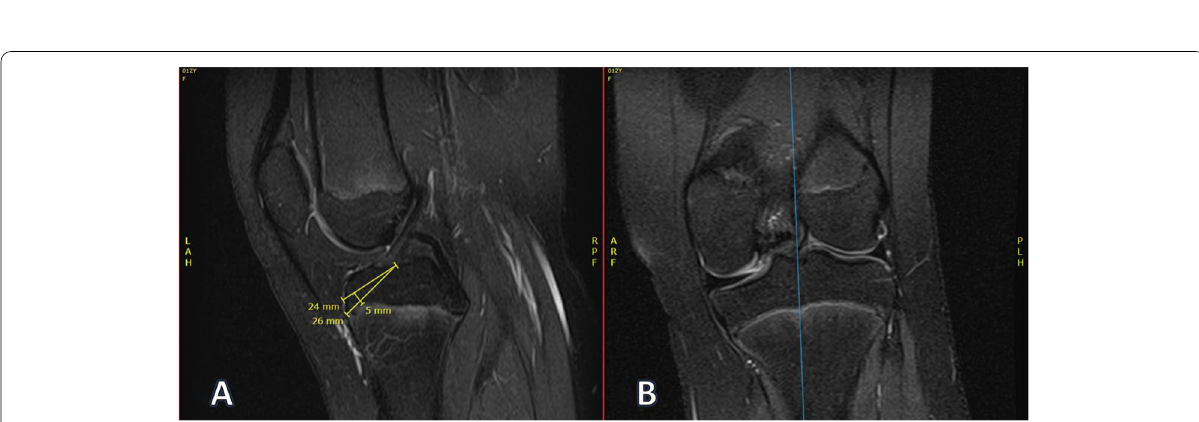
Fig. 5 Example tibial epiphysis tunnel length measurements. A Tibial physeal sparing length (24 mm) and tibial maximum oblique length (26 mm). B Corresponding coronal location of measurements. These measurements were made on the most medial cut that displayed the ACL